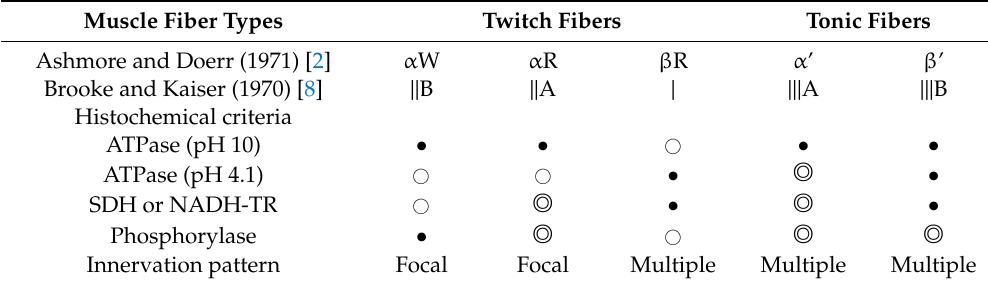
Table 1. Classification of different fiber types in chicken muscle. The twitch muscle fibers with high myofibrillar adenosine triphosphatase (ATPase) after alkaline preincubation and low activity after acid preincubation are called ⍺ fibers. They are divided further into two subtypes, ⍺ W fibers with low oxidative activity and ⍺ R fibers with high oxidative activity (succinic dehydrogenase, SDH) or nicotinamide adenine dinucleotide tetrazolium reductase (NADH-TR). The fibers with the reverse ATPase and high oxidative activity are called β R fibers. The tonic muscle is also heterogeneous in fiber types with respect to ATPase activity, which do not reverse in myofibrillar ATPase pattern when exposed to acidic or alkaline preincubation. The β ’ fibers with more intense reaction tend to locate centrally among groups of lighter-staining ⍺ ’ fibers in a similar way in twitch muscles, which consist of β R fibers located centrally within groups of ⍺ fibers. The classification in mammals was made by Brook and Keizer [8]. The multiple innervation of β R fibers in twitch muscles was reported for the first time by Ashmore et al. (1978) [5,6].